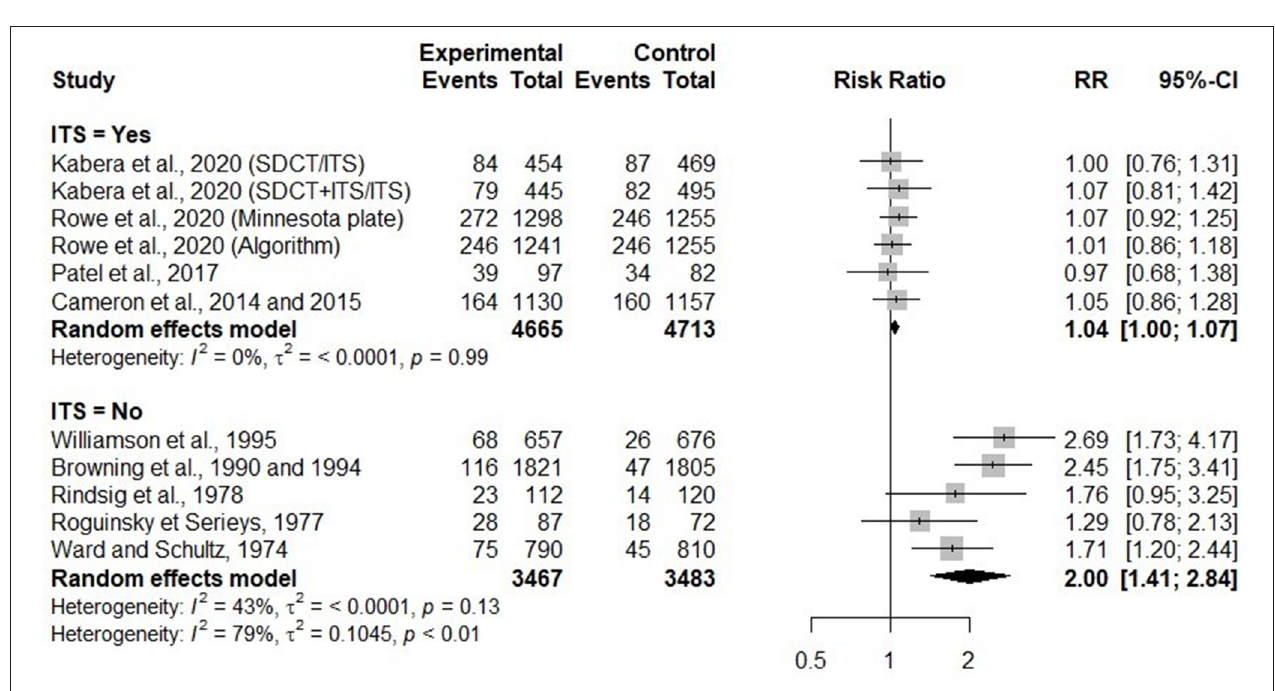
FIGURE 3 | Forest plots showing the proportion of antimicrobial use reduction.